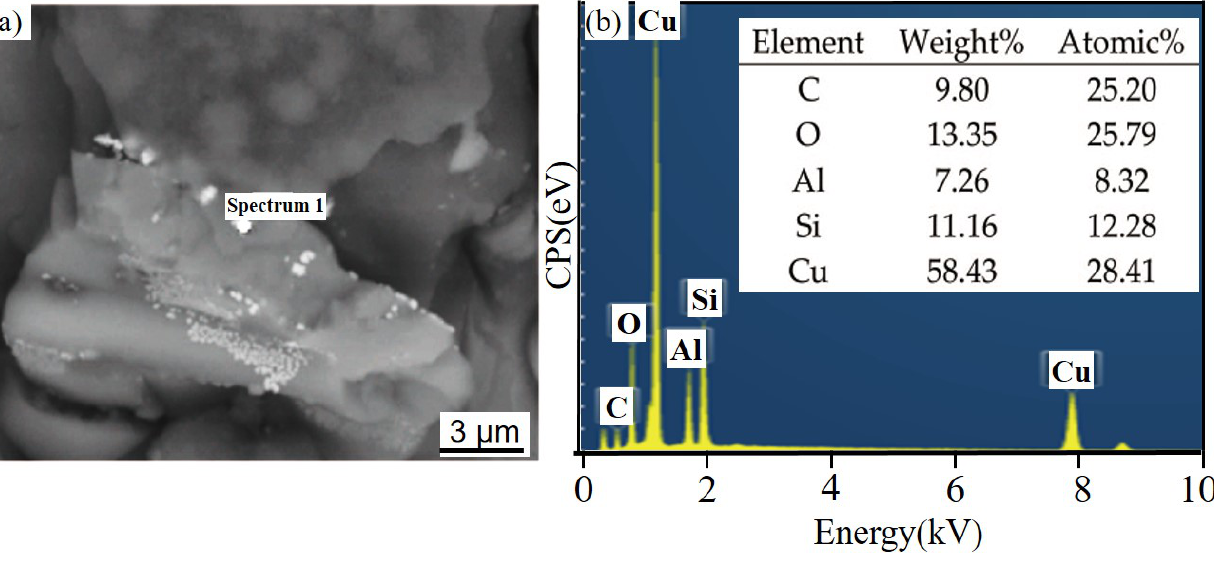
Figure 13. EDS of SiC phase at the interface of SiC 3D /6061Al after SL for 21 days. ( a ) SEM image of SiC phase; ( b ) EDS of SiC phase.